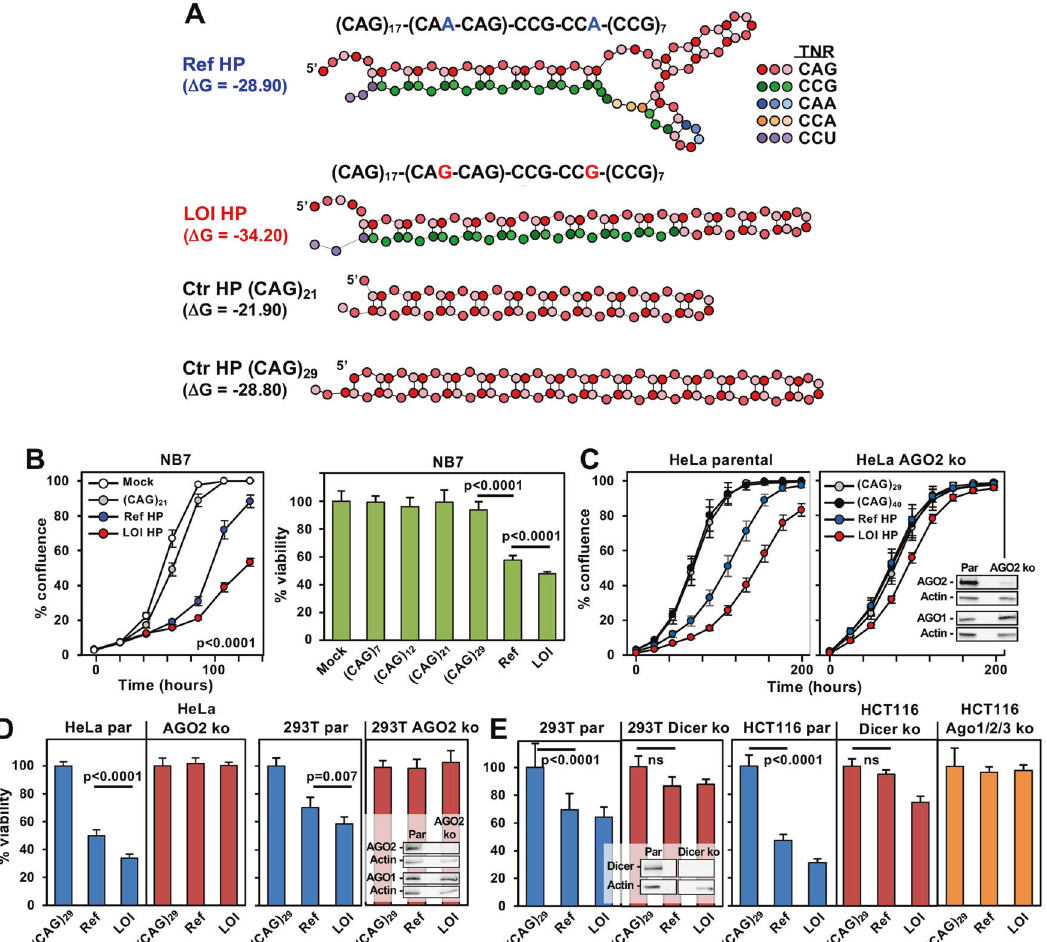
Fig. 3 A LOI mutant HP mimetic is more toxic through RNAi than the reference HP. A Secondary structures of the synthesized RNA HPs including two control HPs comprised of pure CAG repeats. Different TNRs are shown in different colors. Binding energies are given. B , left , change in con fl uency over time of NB7 cells transfected with three of the HPs at 2.5 nM. B , right , viability (ATP assay) of NB7 cells 4 days after transfection with the different HPs (1 nM). Fold change is shown relative to lipid treated cells. Two-way ANOVA is shown. C Change in con fl uency over time of HeLa parental or AGO2 k.o. cells transfected with four of the HPs at 25 nM. D , left panel , viability of HeLa parental or AGO2 k.o. cells 4 days after transfection with the different HPs (25 nM). D , right panel , E Viability of indicated cells 4 days after transfection with the different HPs (10 nM for 293T cells, 2.5 nM for HCT116 cells). Fold change is shown relative to (CAG) 29 control. Average of 3 – 6 replicates are shown − / + SE ( B , left panel, C ) and mean of 3-6 replicates are shown − / + SD ( B , right panel, D , E ). par = parental. P -values (Student ’ s t -test) are shown in B , right panel, D and E . ns, not signi fi cant. Inserts show Western blot analyses of the parental and corresponding mutant cell